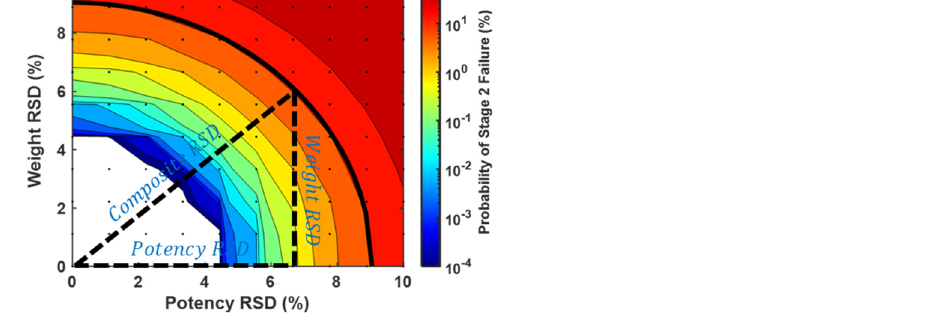
Figure 3. The probability of failing CU requirements was found to be qualitatively proportional to the root sum of squares of bulk mini-tablet weight RSD and potency RSD (Equation (1)). The composite RSD (bold solid line) is overlaid on the simulated probability of stage 2 failure with a fill count equal to 1 and a fill count probability equal to 0%. A similar trend is observed for other fill counts as well (Figure 4).